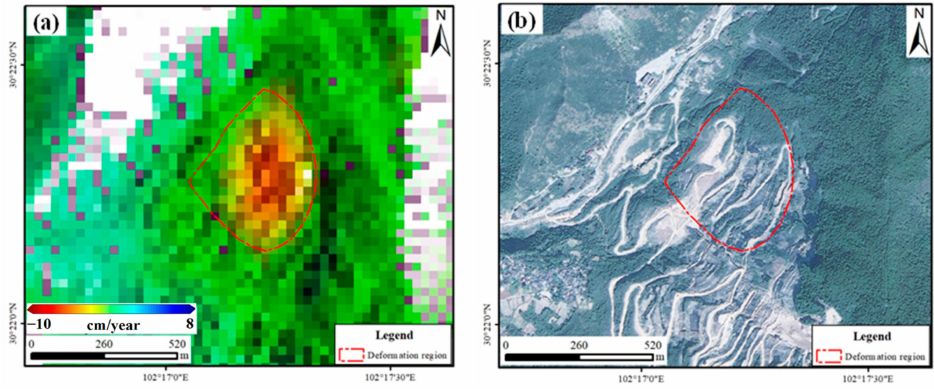
Figure 7. ( a ) Deformation map of the surface area from InSAR. ( b ) Optical satellite image of the ground deformation area on 30 September